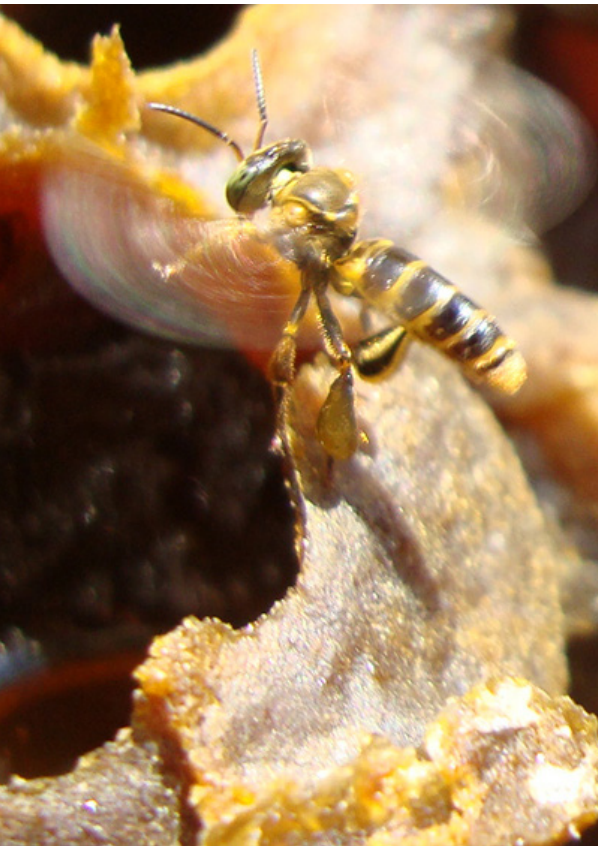
Fig 1 . Worker of Tetragona clavipes taking flight. (Photo: Raoni Duarte)